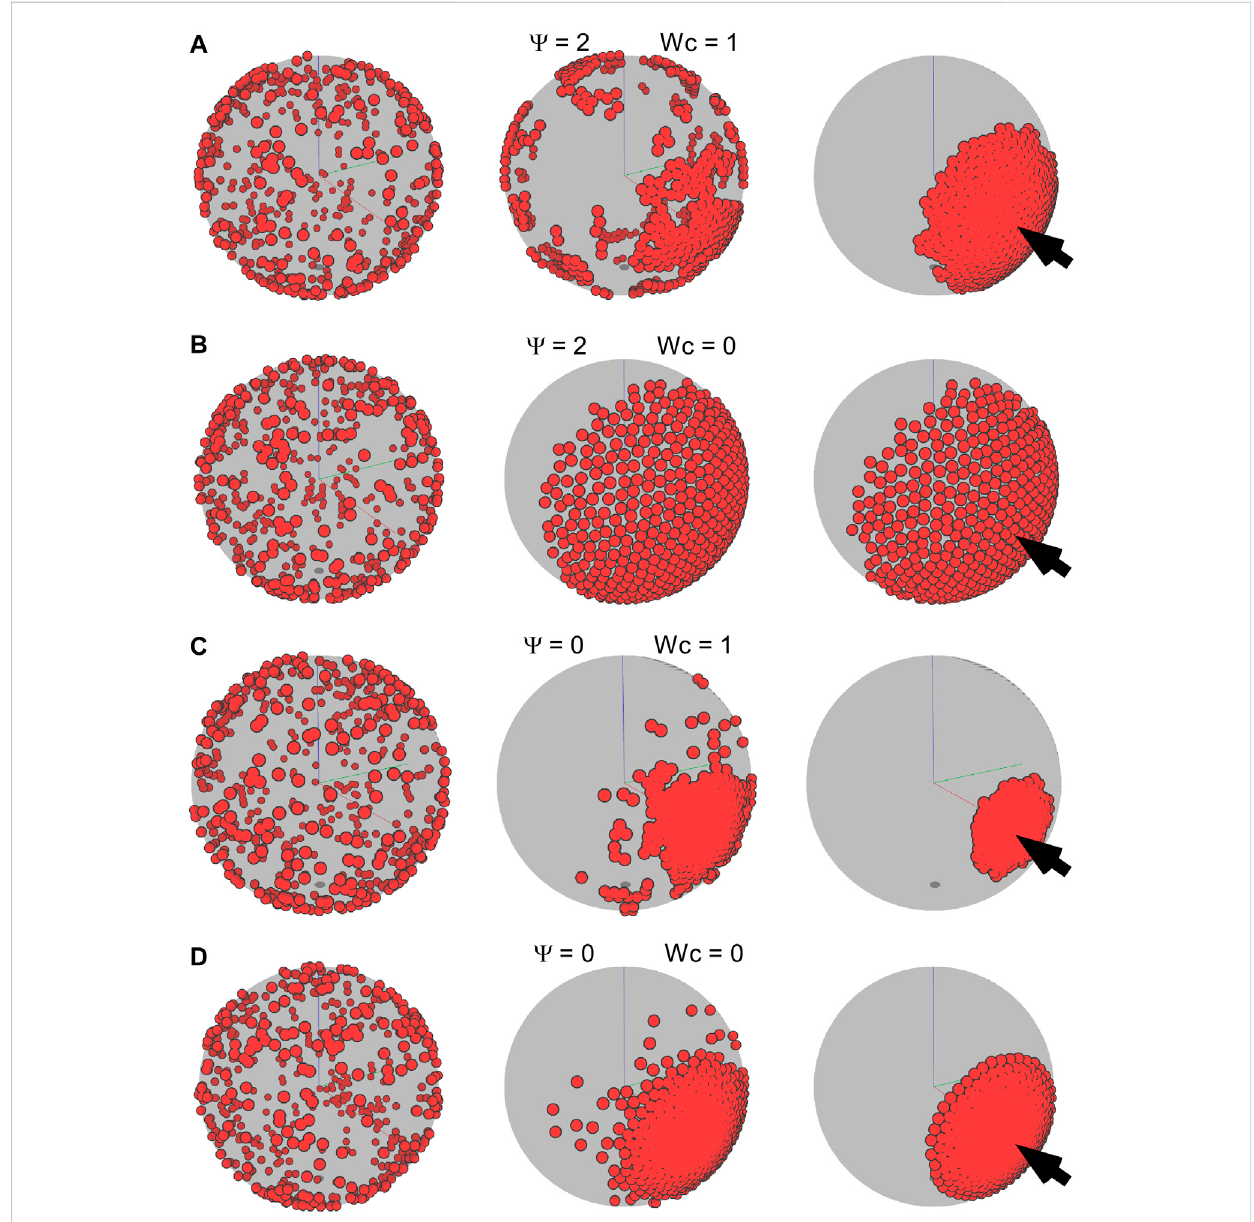
FIGURE 8 Frames of different time steps for an environmental guidance system (external taxis). For all simulations, f tax is 1 and ϕ (cid:1) 0 . 2 (500 cells on asphere of radius 25). We varied ψ and W c to explore the emerging aggregation dynamics and phenotypes. (A) ψ (cid:1) 2; W c (cid:1) 1. (B) ψ (cid:1) 2; W c (cid:1) 0. (C) ψ (cid:1) 0; W c (cid:1) 1. (D) ψ (cid:1) 0; W c (cid:1) 0.TheYSLisdrawnasatransparentgraysphere;hence,thecellsonthefarsideappeardarker.Thethree-dimensionalperspectivemeansthat thesecellsalsoappearsmaller.Theimagesintheleft,middle,andrightcolumnsrepresentthetimes0,50,and500,respectively,exceptforC,where the fi nal con fi guration is reached at time 72.5. The arrow indicates the position of the organizing